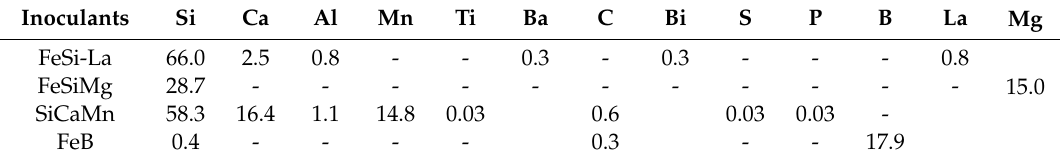
Table 4. Chemical composition of the inoculants used to manufacture the shell (wt.%). Remainder Fe.